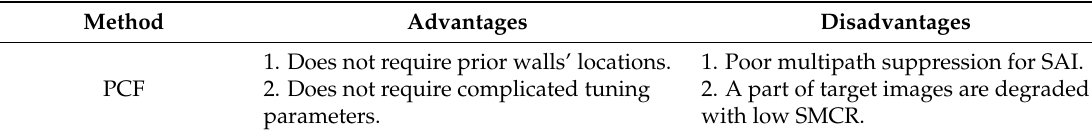
Table 3. The advantages and disadvantages of different